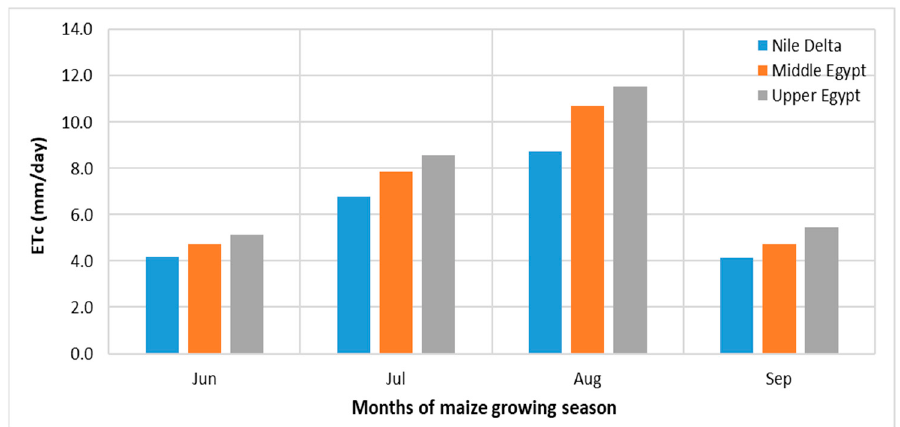
Figure 5. Maize crop evapotranspiration for three agro-ecological zones as the mean of five-year period from 2015 to 2019.